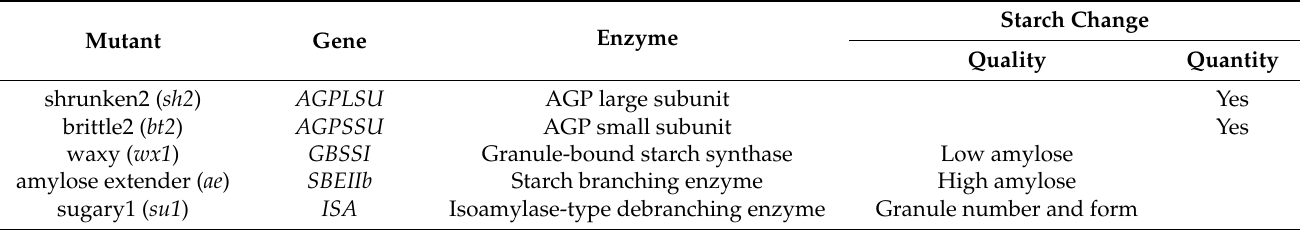
Table 1. The list of corn mutations effect in starch production and their functionalities in